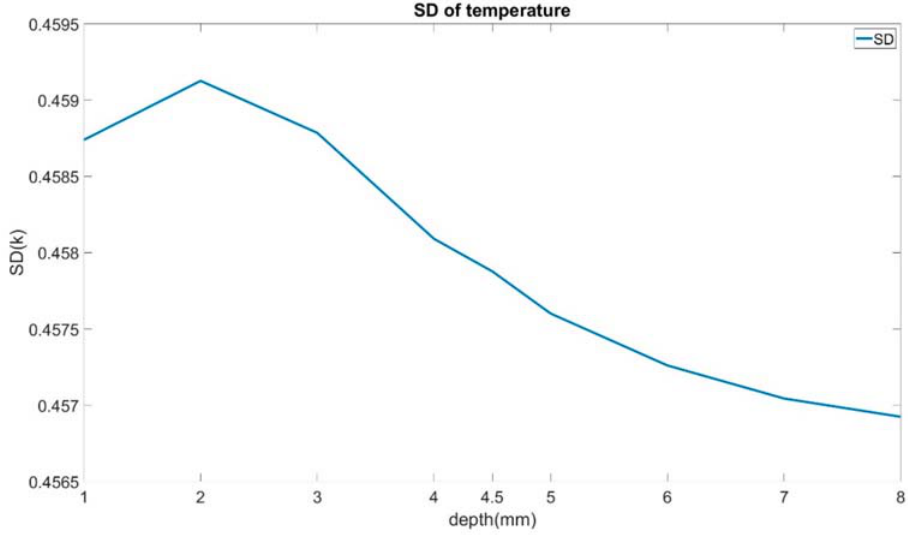
Figure 12. Standard deviation of all models’ temperature